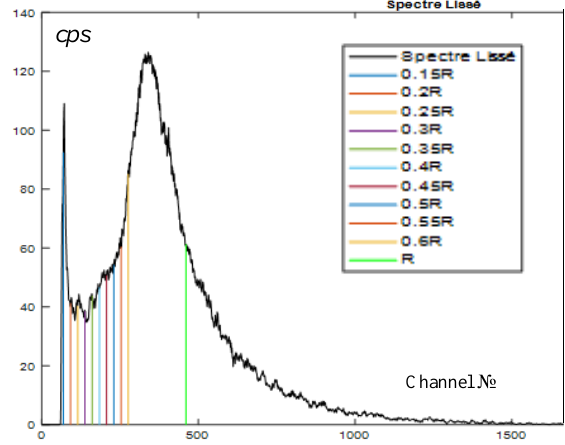
Fig. 1. Spectrum of U-235 fragments obtained with FC #676 in the BR1 empty cavity.